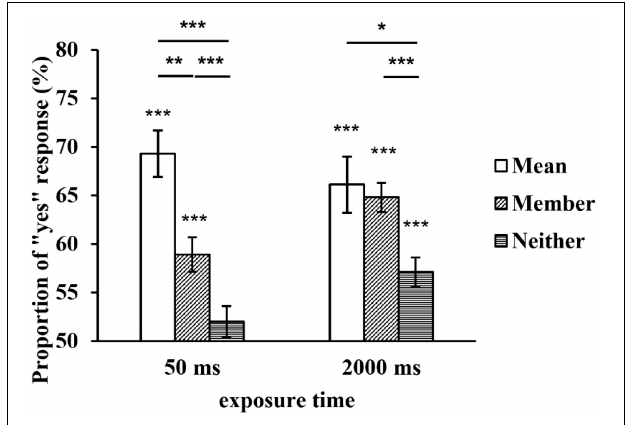
FIGURE 3 | The proportion of “yes” responses to the test faces at two exposure times. * p < 0.05, ** p < 0.01, *** p < 0.001. SEMs are